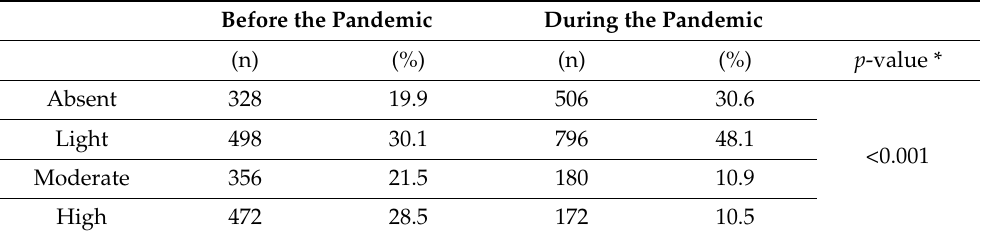
Table 2. Physical activity levels before and during the pandemic. Before the Pandemic During the Pandemic (n)